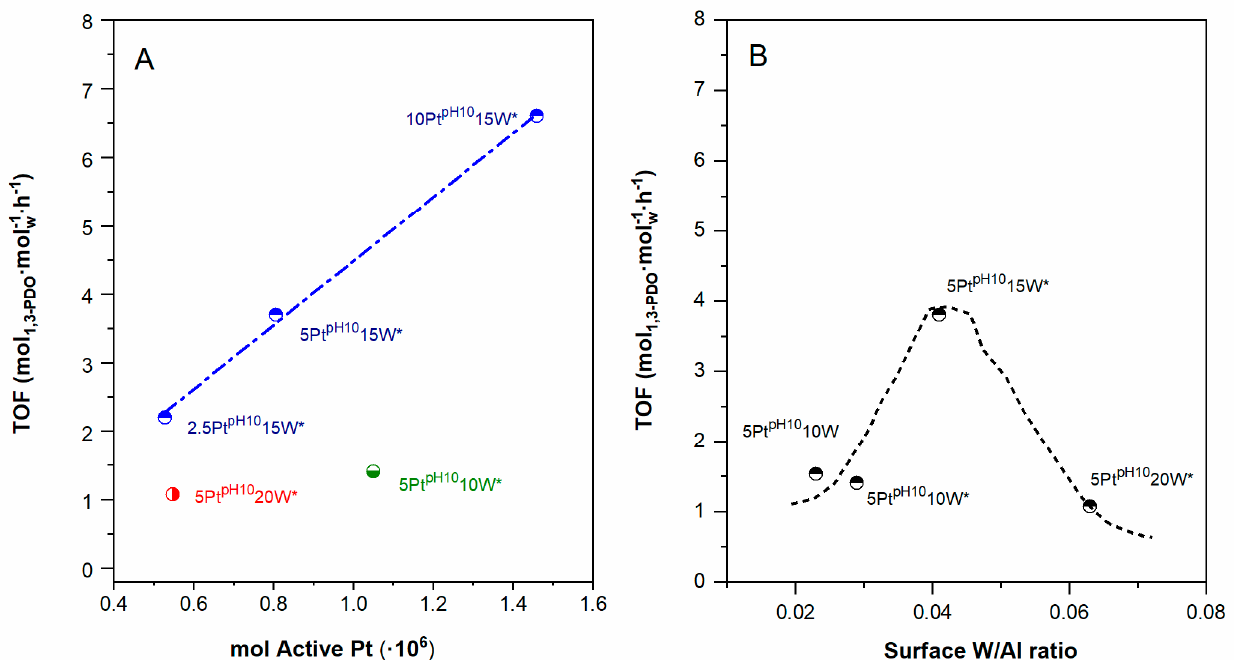
Figure 6. ( A ) Correlation between TOF 1,3-PDO-W , obtained at similar conversion values (15–20%), and mol of active Pt present in the reaction, for catalysts presenting different Pt and/or W contents. ( B ) For catalysts with 5 wt.% Pt impregnated at pH 10, effect of the surface W/Al ratio (determined by XPS). Operating conditions: 473 K, 55 MPa H 2 , 5 wt.% glycerol water Scheme 0. g cat · g glycerol − 1 . The * symbol refers to the pH value of 1.5 during tungsten impregnation.